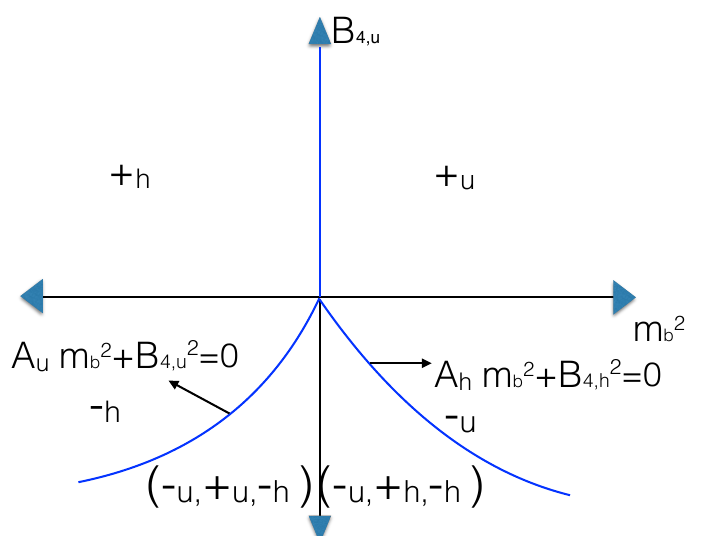
Figure 24. A graph of the domain of existence of solutions to the gap equation for (cid:30) 2 > x 6 > (cid:30) 1 . We have a single solution outside the two parabolas, but three di(cid:11)erent solutions between these two parabolas. The + u and solutions reduce to each other on the left parabola while the + h and (cid:0) u (cid:0) h solutions reduce to each other on the right parabola. Moreover the + u and + h solutions continue into each other through a second order phase transition along the negative B 4 ;u axis. It follows that the space of solutions represents a single cover of parameter space outside the two parabolas, but a triple cover of parameter space inside the two parabolas. Note that the (+ u ; ) and (+ h ; ) (cid:0) u (cid:0) h phases correspond to U( N ) (cid:20) and U( N 1) (cid:20) theories, respectively. (cid:0)